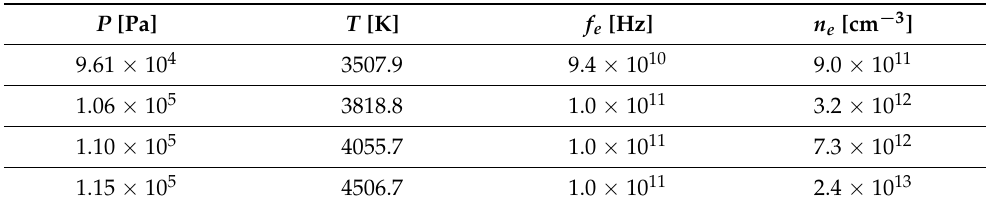
Table 2. The parameters of the gas in the second area, electron density and collision frequency (with pressure and temperature), at 220